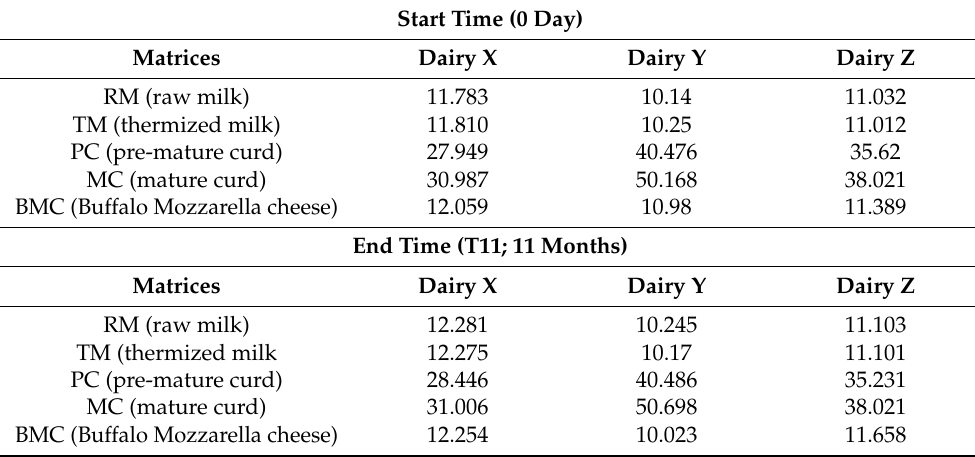
Table 3. Densitometric analysis of the matrices of the three dairies: (a) Dairy X; (b) Dairy Y; (c) Dairy Z. The results reported are referred to the beginning of the experiment (T0; 0 day) and to the end of the freezing storage (T11; 11 months). Values are expressed as % of the amount of γ 4-casein ( β -CN (69-209)) normalized against to α s1- α s2- β CN